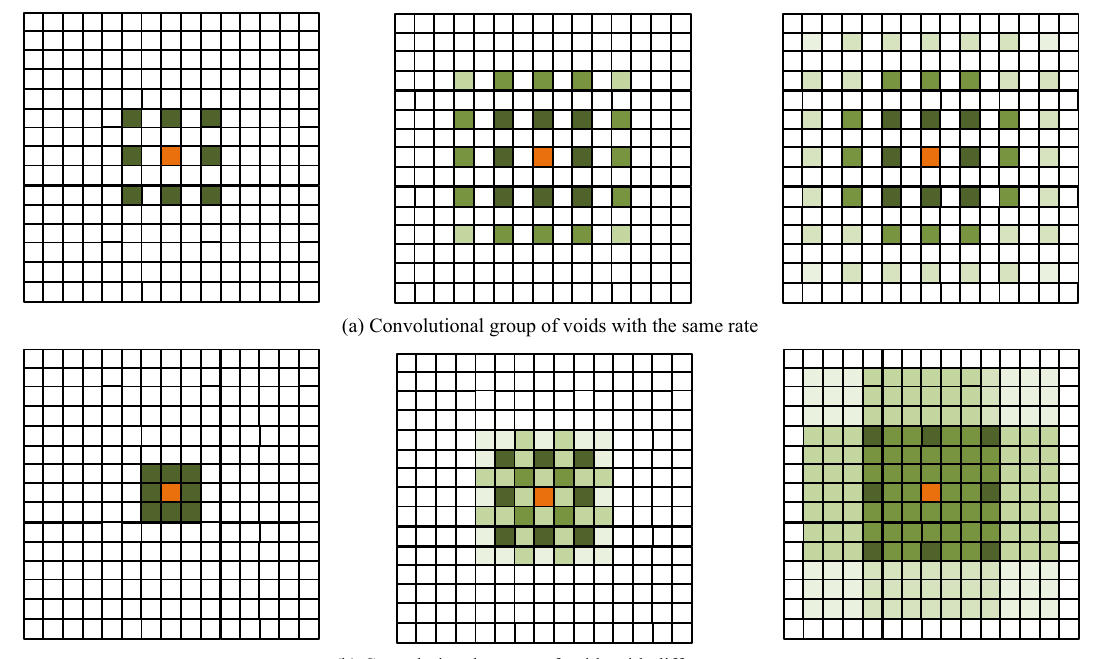
Fig. 7 Atrous convolution group combined with different dilation rates